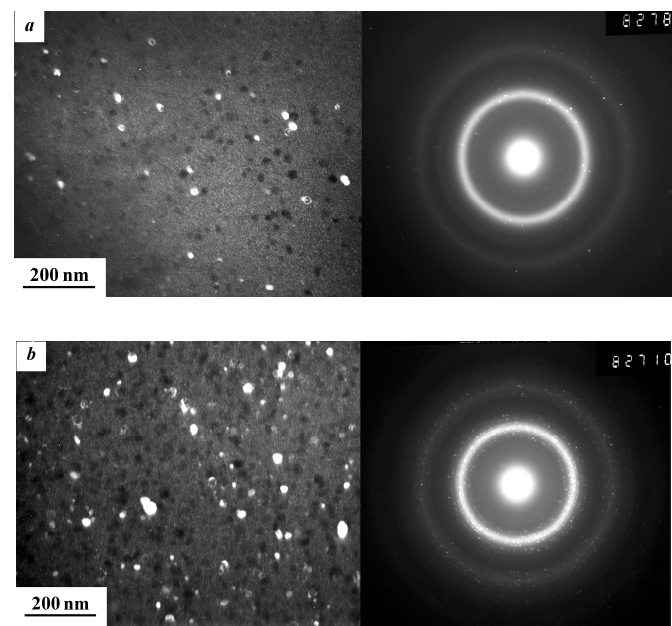
Figure 3. Dark-field images of the of Fe 53.3 Ni 26.5 B 20.2 AA structure subjected to HPT to N = 3 ( a ) and N = 9 ( b ) and the corresponding selected area electron diffraction ( SAED) patterns.